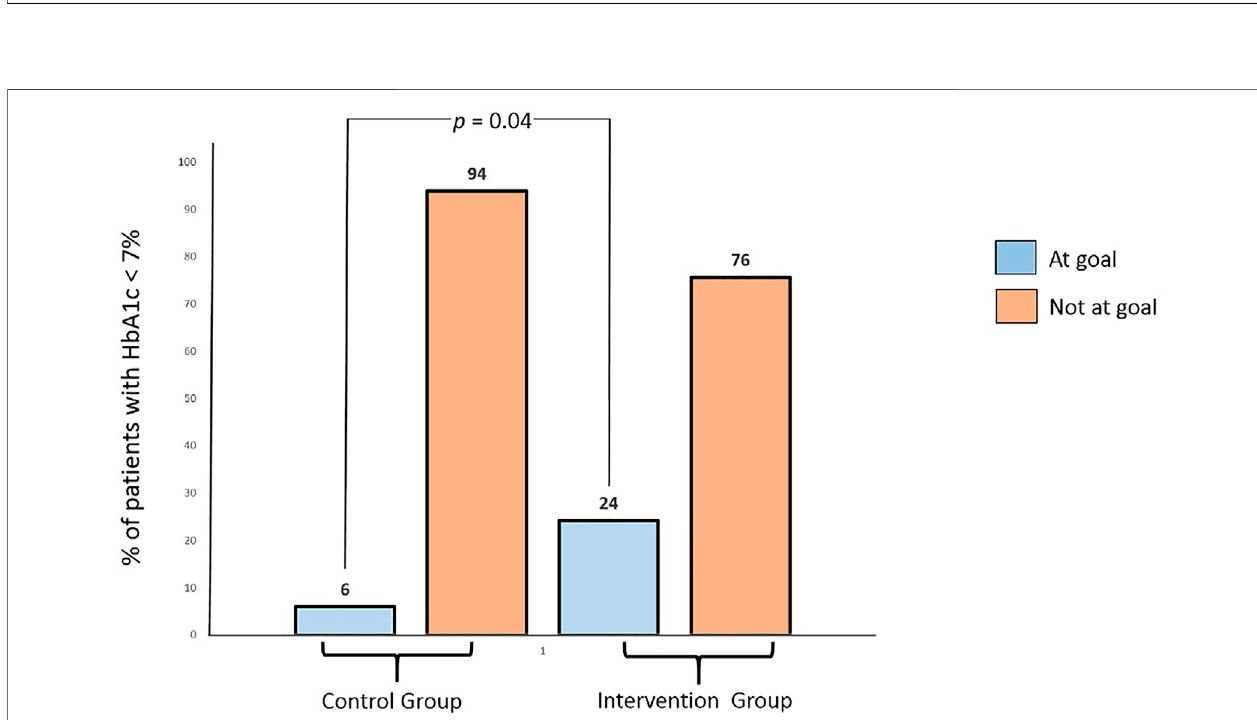
FIGURE 4 | Percentage of patients in the control and intervention groups who achieved or did not achieve the goal of glycemic control (HbA1c < 7%) at the end of study (after 6 months).